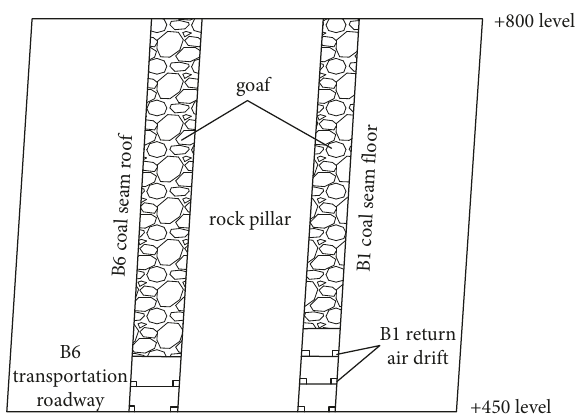
Figure 1: Mining layout of working face in Wudong coal